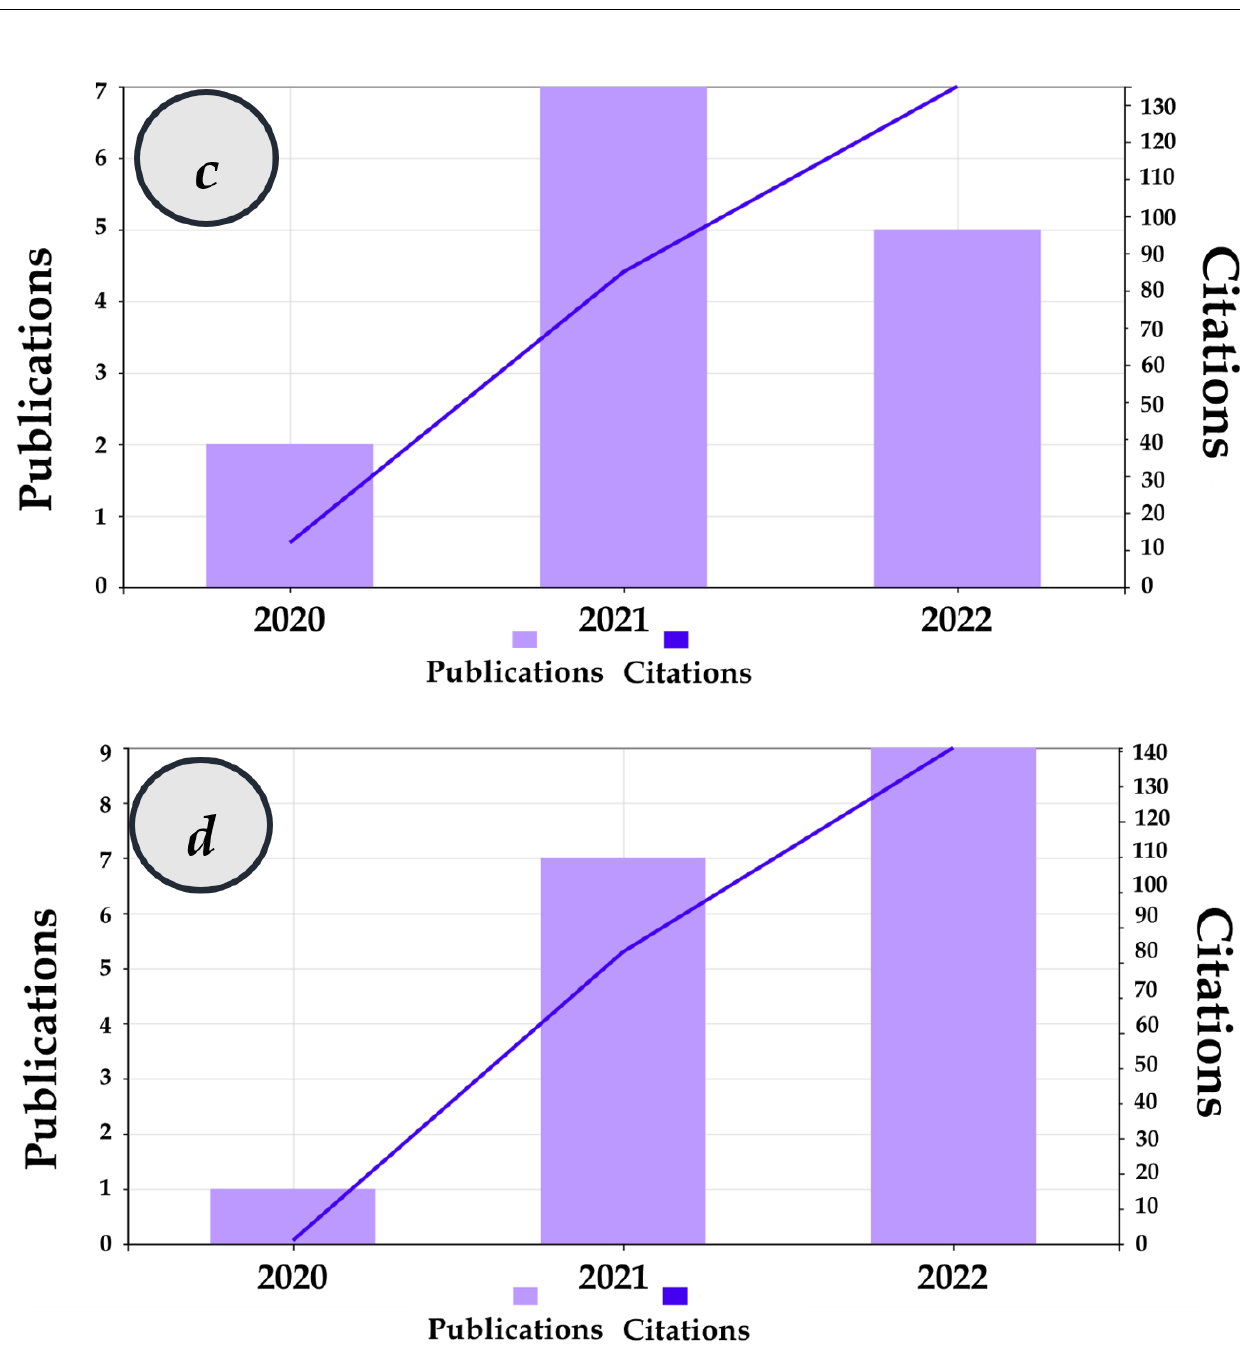
Figure 12. Trends of BIM, IoT, and DT in Construction: BIM “AND” IoT “AND” Digital Twin “AND” Construction ( a ); BIM “AND” Internet of Things “AND” Augmented Reality “AND” Construction ( b ); Building Information Modeling “AND” IoT “AND” Digital Twin “AND” Construction ( c ); and Building Information Modeling “AND” Internet of Things “AND” Digital Twin “AND” Construction ( d ).